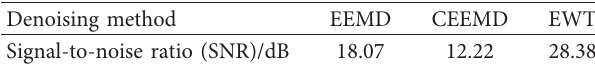
( t ) signal and f sig